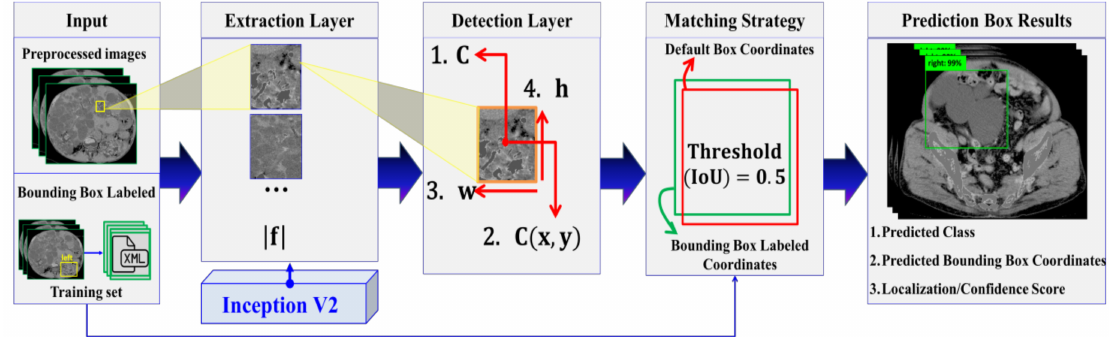
Figure 5. The architecture of automatic ADPKD detection model, where | f | , C(x, y), w, h, and V2 refer to as total number of feature maps, center bounding box, width, height, and version 2,